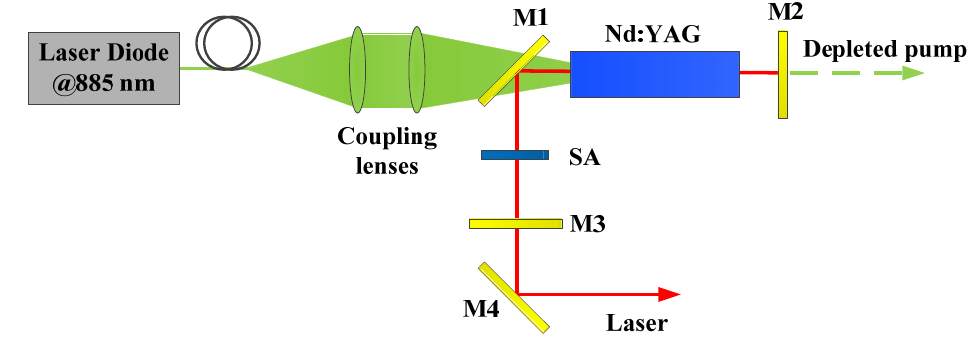
Figure 1. Experimental scheme of the Nd:YAG laser.